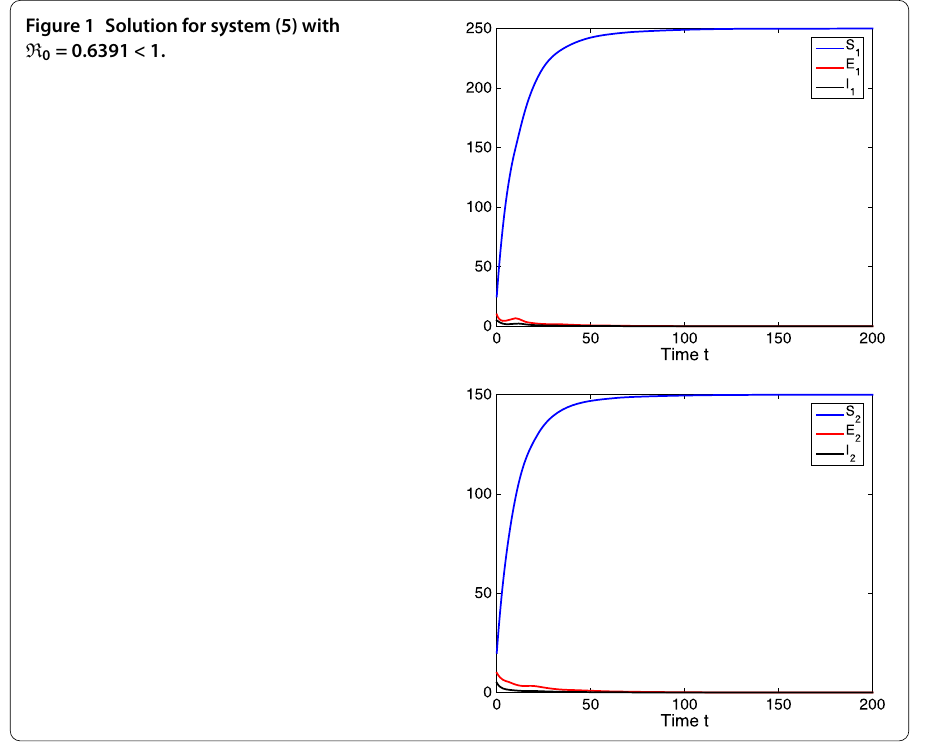
Figure 1 Solution for system (5) with R 0 = 0.6391 <